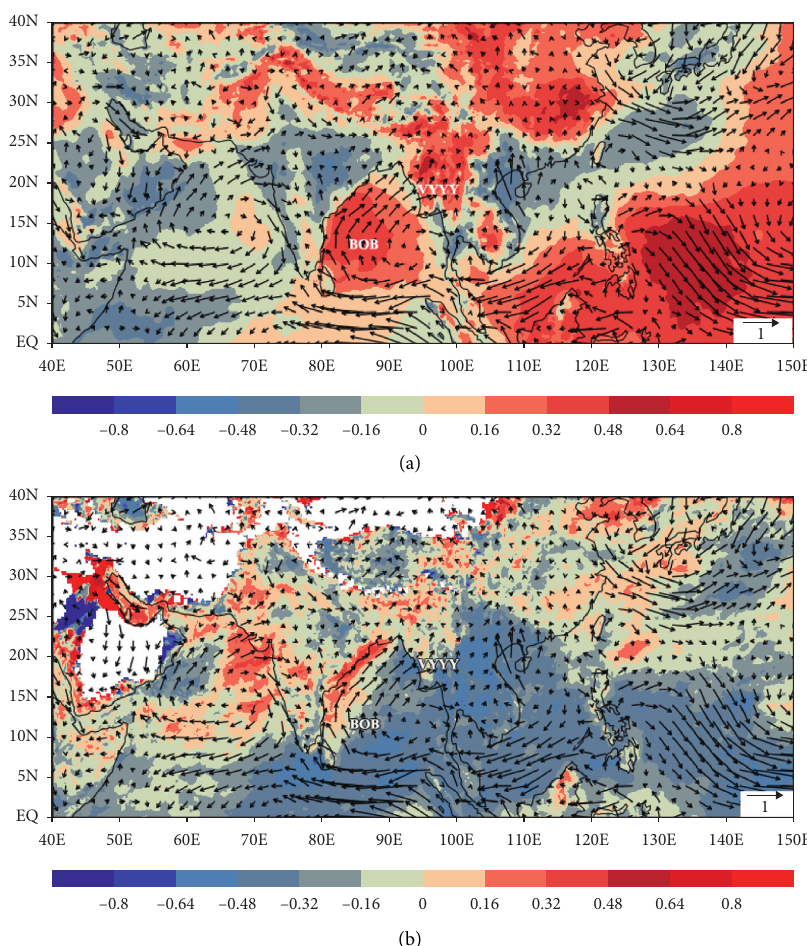
Figure 15: The composite of correlation between annual convective rainfall over VYYY and (a) annual anomalies of CAPE Index (J kg − 1 ) of the region and (b) annual anomalies of convective inhibition (J kg − 1 ) of the region (ms − 1 ), with annual 10 m component wind (ms − 1